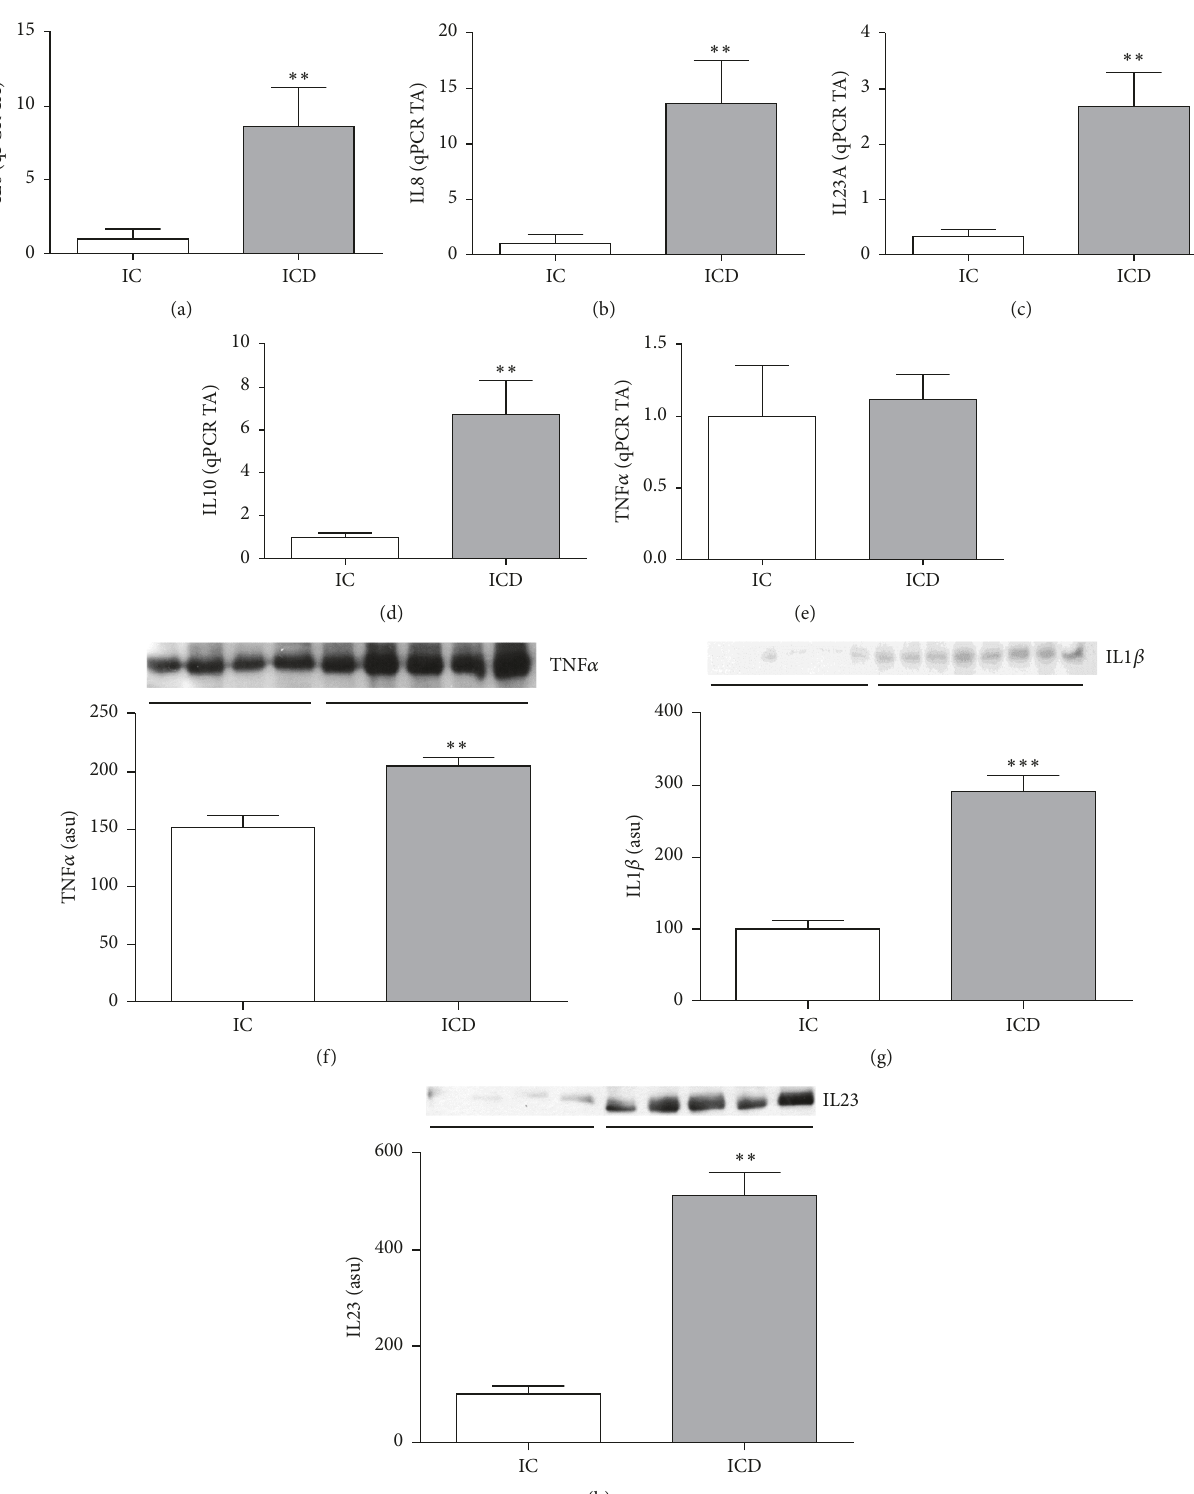
Figure 2: Evaluation of cytokines gene expressions in the intestinal mucosa of Crohn’s disease patients. Inflammatory signaling proteins reveal a proinflammatory pattern in the intestinal mucosa of Crohn’s disease patients. mRNA levels (qRT-PCR) of IL6 (a), IL8 (b), IL23A (c), IL10 (d), and TNF 𝛼 (e), in intestinal mucosa of CD patients (ICD Group) compared to controls (IC Group). Western blot analysis of TNF 𝛼 (f), IL1 𝛽 (g), and IL23 (h) in intestinal mucosa of CD patients (ICD Group) compared to controls (IC Group). Each band represents one patient. For ICD, 𝑛 = 10 ; for IC, 𝑛 = 8 , ∗ 𝑝 < 0.05 , ∗∗ 𝑝 < 0.01 , and ∗∗∗ 𝑝 < 0.001 versus control. TA: transcription amount. ASU: arbitrary scanning